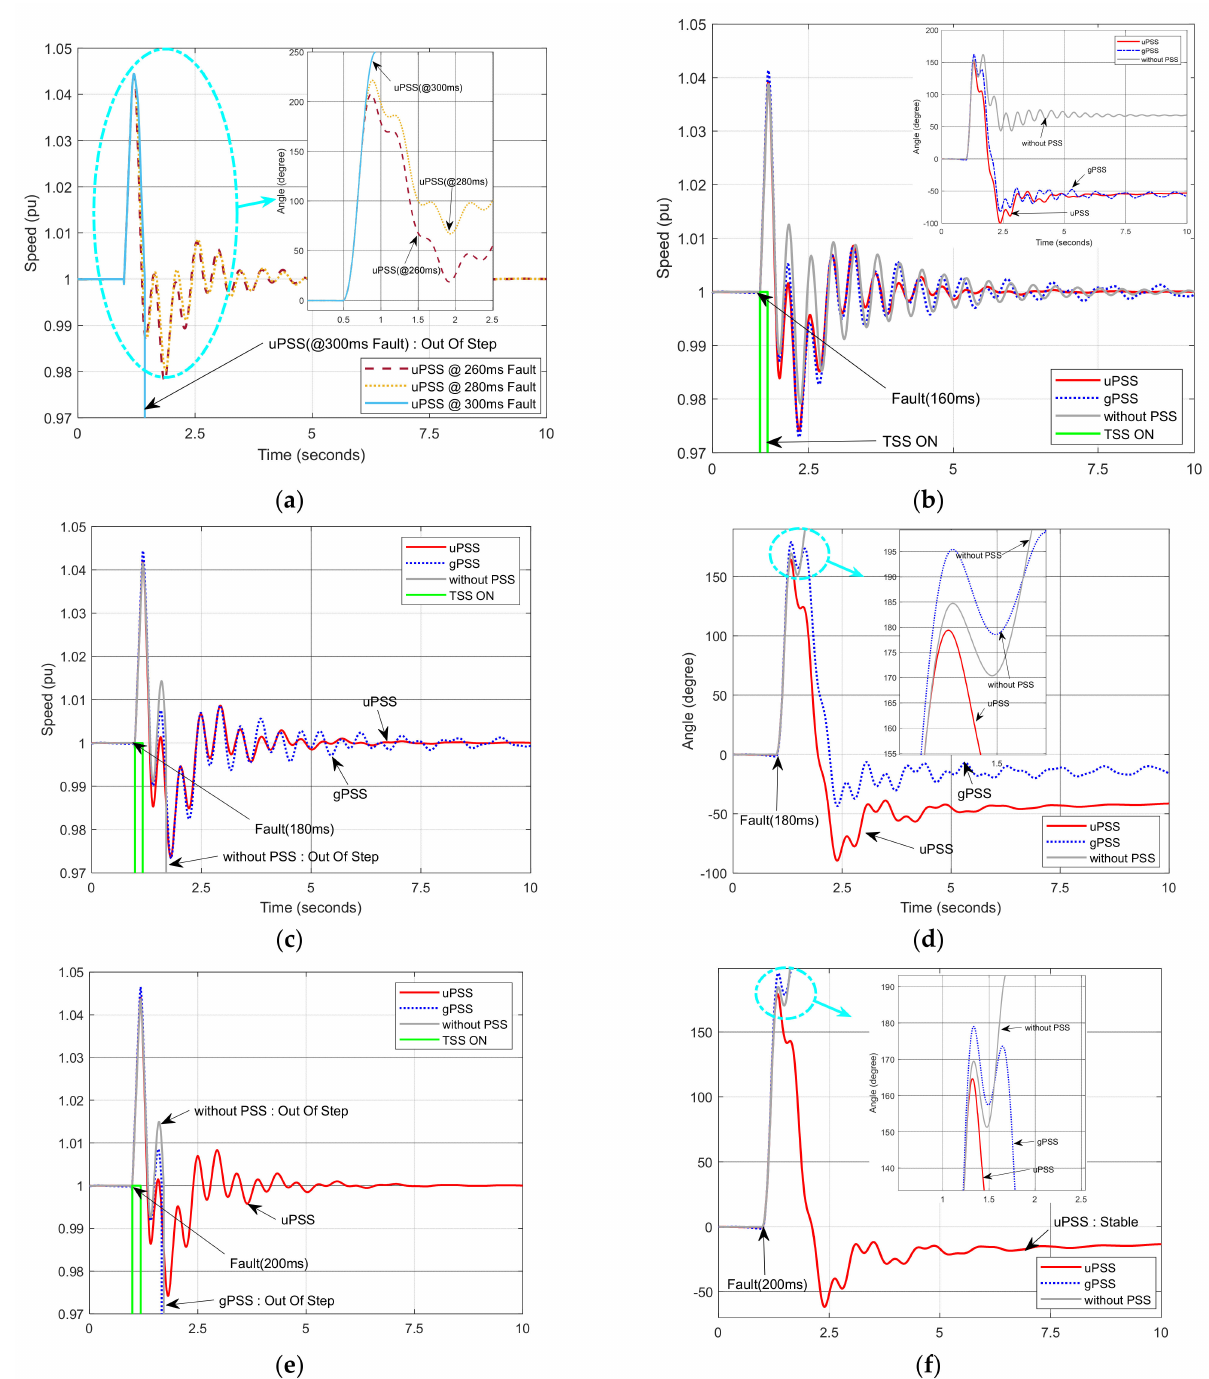
Figure 12. The effects of the µ PSS on transient stability in the case of the three-phase short-circuit fault (fault resistance 0.001 Ω ; the fault location is marked with X in Figure A1): ( a ) critical clearing time of the µ PSS (dashed line: 260 ms; dotted line: 280 ms; solid line: 300 ms). ( b ) In the case of 160 ms three-phase short-circuit fault ( µ PSS: stable; others: unstable (out of step)). ( c , d ) In the case of 180 ms three-phase short-circuit fault (the case without a PSS: out of step), the trend of speed and phase angle. ( e , f ) In the case of 200 ms three-phase short-circuit fault with transient state stabilizing (TSS) signals, the trend of speed (only the µ PSS case is